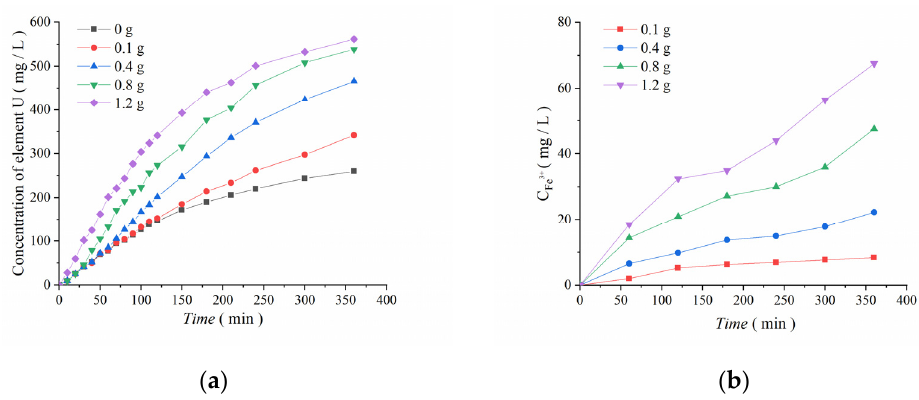
Figure 1. Element U ( a ) and Fe 3+ ion ( b ) concentration changes with time under different pyrite masses.